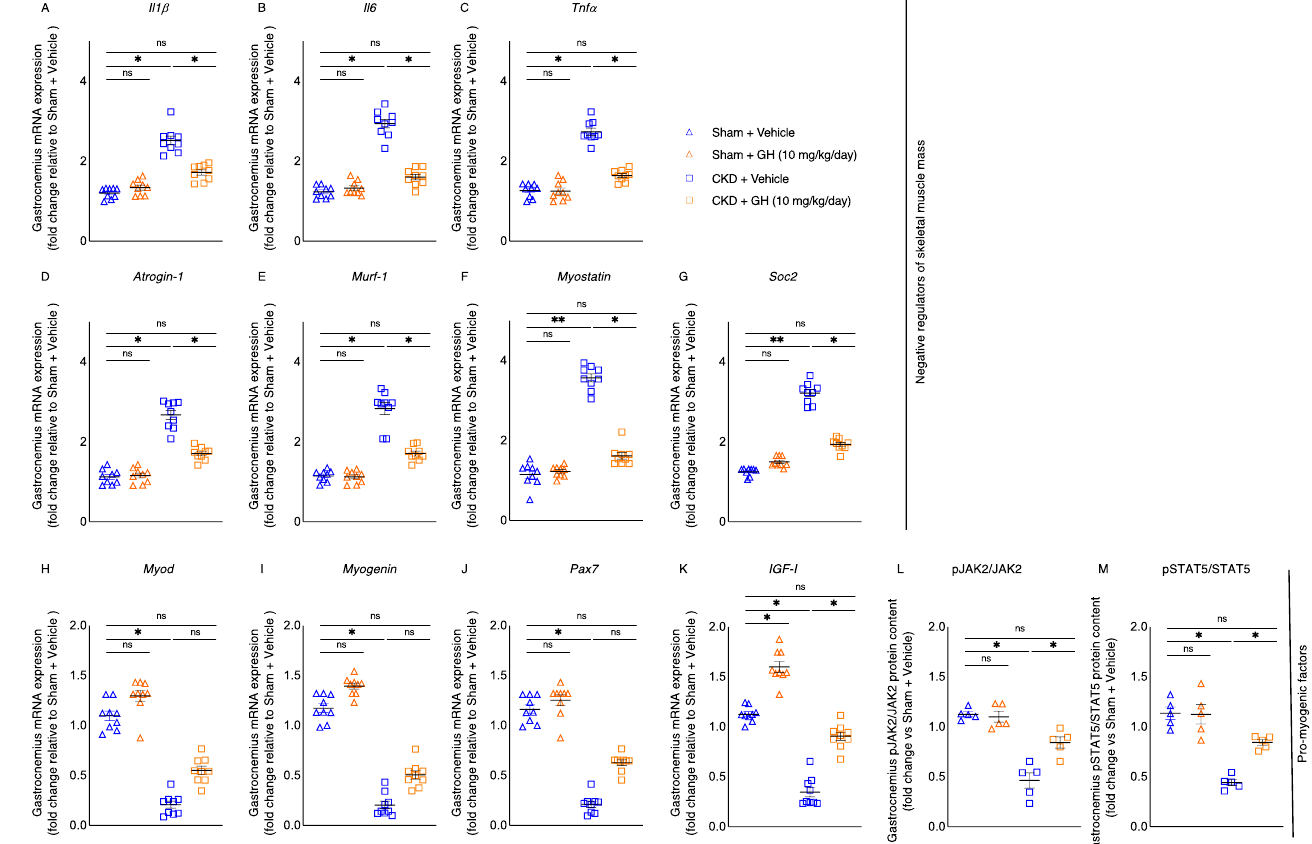
Figure 5. GH reduces muscle-wasting signaling pathways in CKD mice. CKD mice were fed ad libitum, whereas other mouse groups received an energy intake amount equal to that of CKD + Vehicle mice. By using qPCR, the expression of negative regulators of skeletal muscle mass (Il1 β , Il6, Tnf α , Atrogin-1, Murf-1, and Socs2) as well as promyogenic factors (MyoD, Myogenin, Pax7, and IGF-I) in the gastrocnemius muscle was determined ( A – K ). In addition, by using the appropriate ELISA kits, the relative phosphorylated JAK2/total JAK2 ratio and the phosphorylated STAT5/total STAT5 ratio in the gastrocnemius muscle were evaluated ( L , M ). Results are analyzed and expressed as in Figure 2. Data are expressed as mean ± SEM. For comparison of the means between two groups, data were analyzed by Student’s 2-tailed t -test. Posthoc analysis was performed with Tukey’s test. Specific p -values are shown above the bar. ns signifies not significant, * p < 0.05, ** p < 0.01.